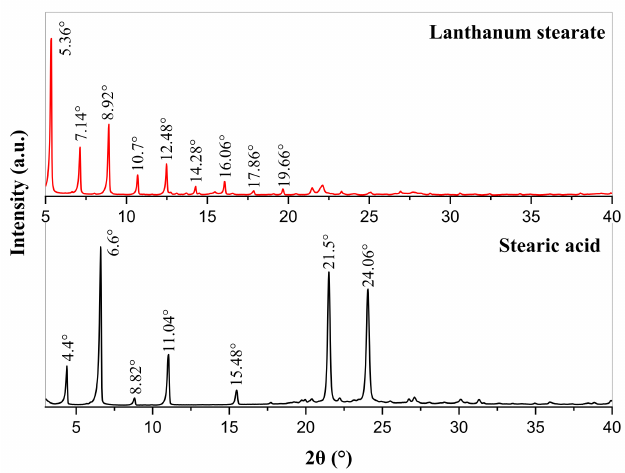
Figure 5. XRD patterns of stearic acid and lanthanum